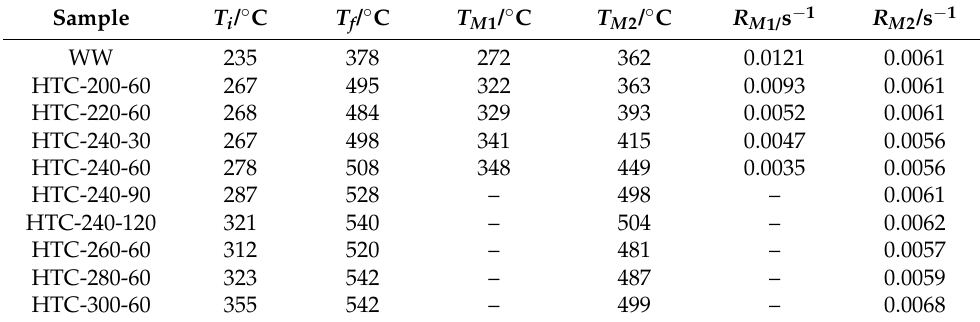
Table 3. Combustion characteristic parameters of different samples.